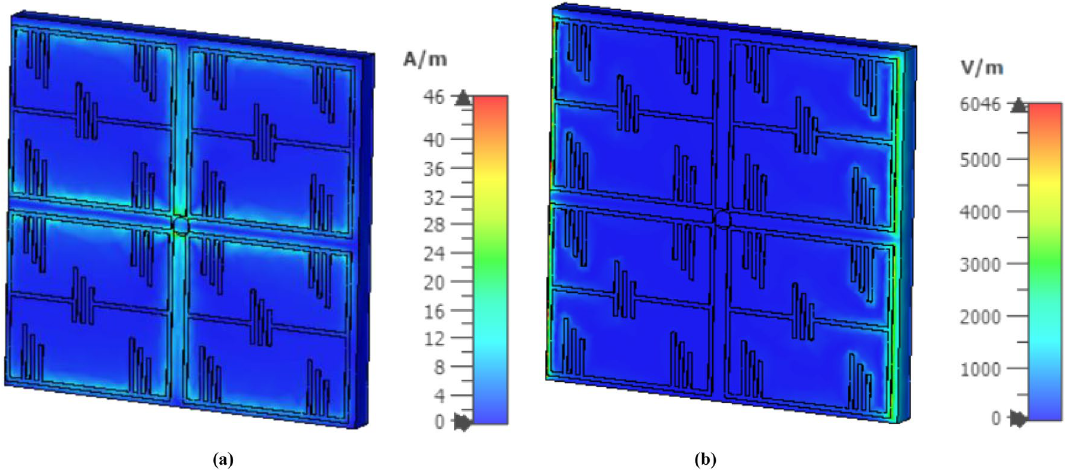
Figure 5. Simulated ( a ) H-field and ( b ) E-field distribution of the designed metamaterial unit cell at 450 MHz (CST STUDIO SUITE 2019, https:// www. 3ds. com/ produ cts- servi ces/ simul ia/ produ cts/ cst- studio- suite) 16 .